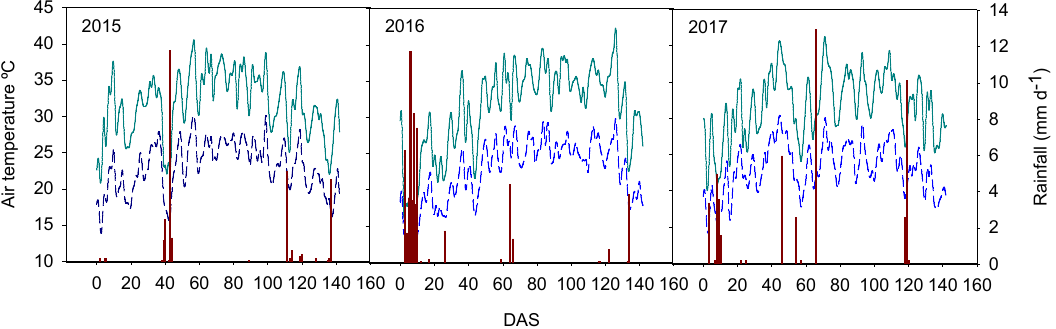
Figure 1. Mean rainfall and air temperature pattern registered at field locations during the rice growing period in 2015–2017. DAS: days after seeding. (-) maximum temperature air, (-) medium temperature air and (-) rainfall.